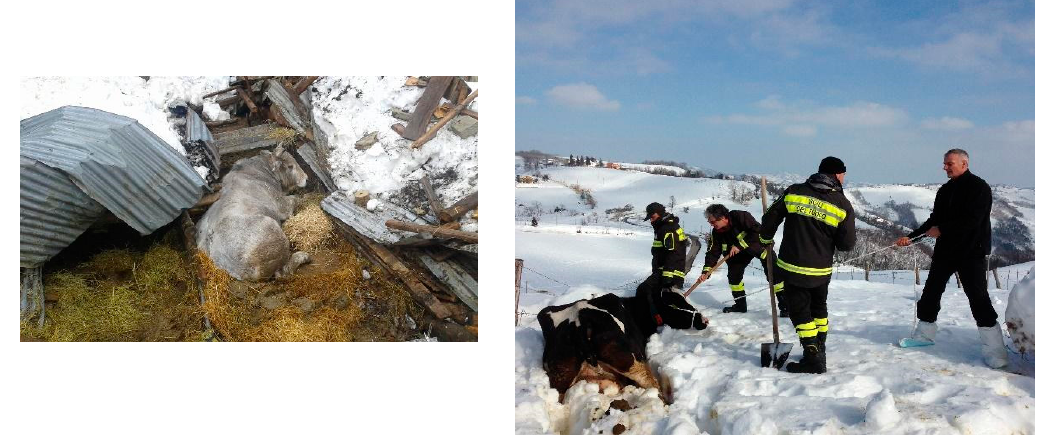
Figure 1. Collapsed sheds in damaged farms in the Province of Teramo and farm animals rescue.